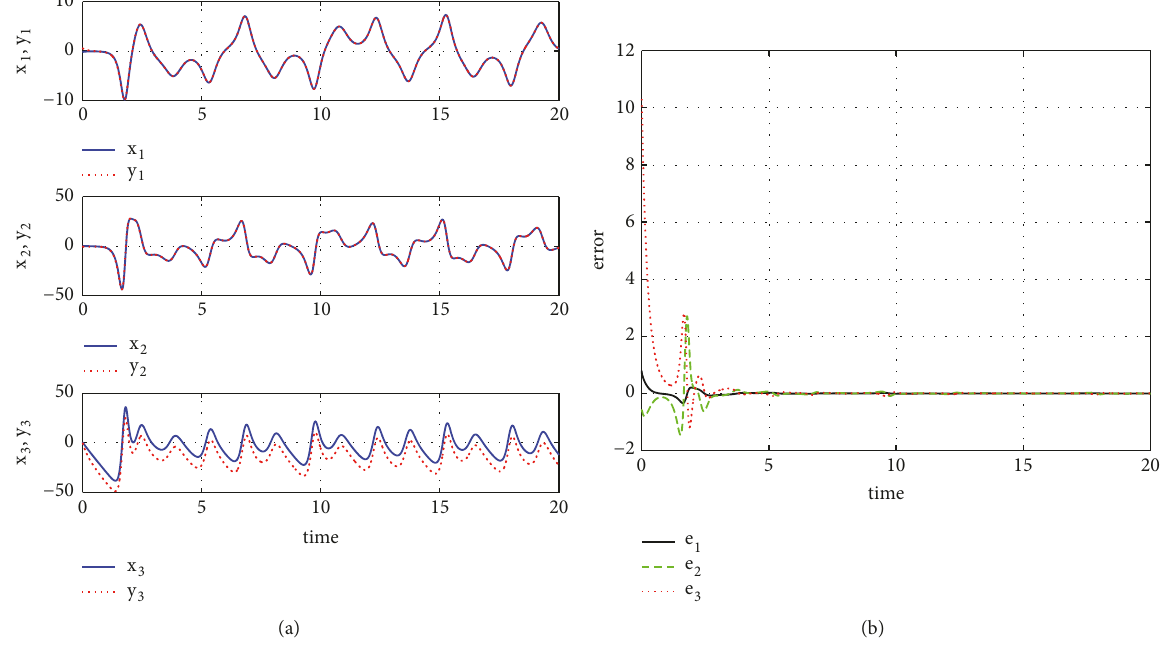
Figure 9: Partial phase synchronization with k 2 =1; k 3 =4: (a) time response; (b) synchronization error.